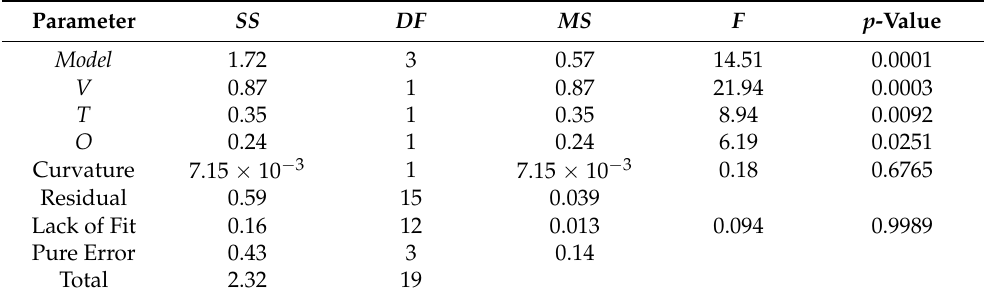
Table 5. Analysis of variance ( ANOVA ) for Ra ( SS : Sum of square; DF : degree of freedom; MS : mean square).